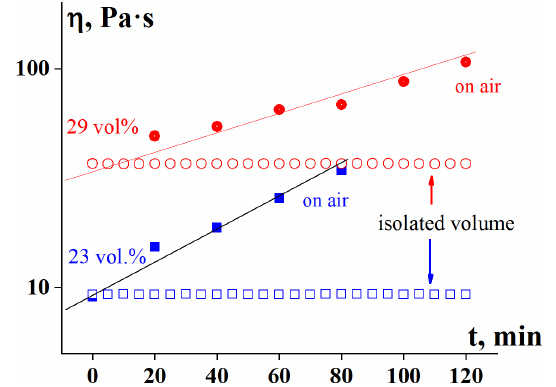
Figure 3: Concentrated dependence of the viscosity of PSu-NMR solutions at 22 ∘